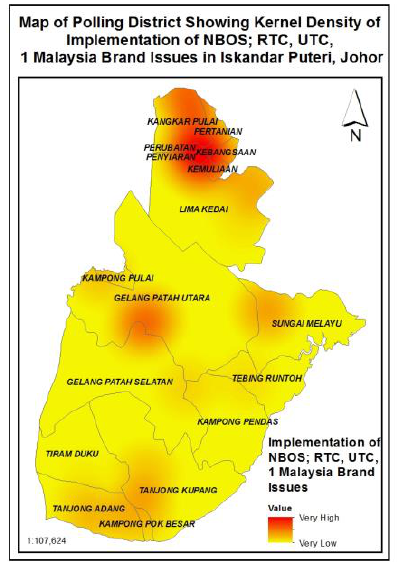
Figure 16. Result of the hot spot maps using KDA for implementation of NBOS; RTC, UTC, 1 Malaysia brand and others issues